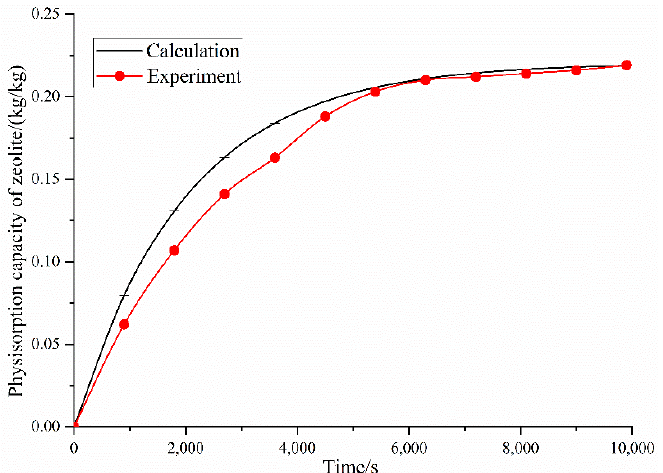
Figure 8. Comparison between experiment and calculation of transient physisorption capacity of zeolite during the adsorption process.